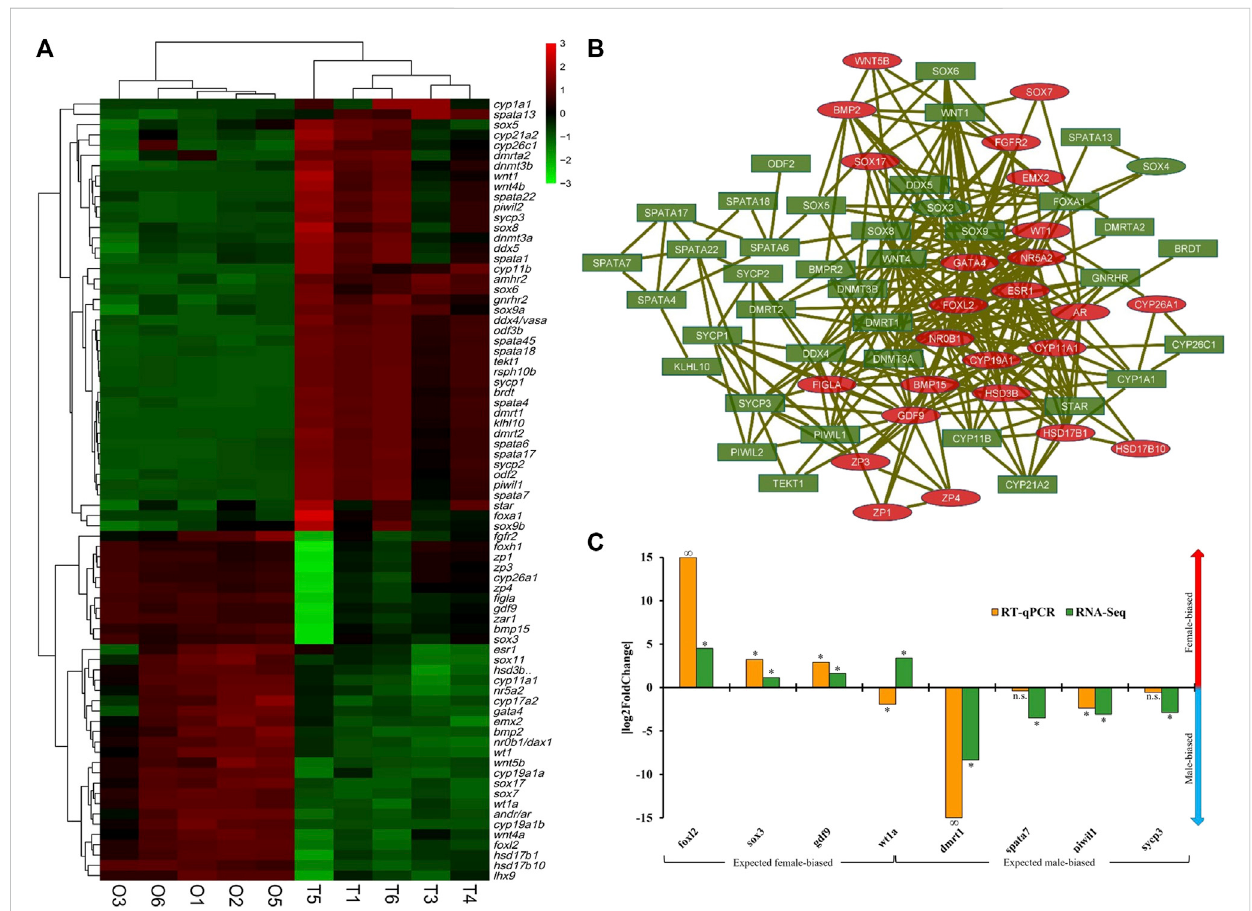
FIGURE 4 Sexually differentially expressed genes (DEGs) of cobia ( p < 0.05). (A) The expression pattern of the representative gonadal genes implicated in sex determination/differentiationofcobia.Intheheatmap,eachrowrepresentsagenelisted ontheright.Eachcolumnstandsfor agonadal sampleofmales (T1, T3, T4, T5, T6) and females (O1, O2, O3, O5, O6). The expression of genes is colour coded from low (green) to high (red). M: male-biased, F: female- biased. (B) The testis upregulated (green with rectangle shapes) and ovary upregulated sex candidate genes (red with oval shapes) were fi ltered into theDEG PPI network complex. Nodes represent genes, edges represent correlationbetweennodes. (C) Validationof theexpressionpatterns ofselected signi fi cantly expressed DEGs from RNA-Seq, using qPCR. Positive |log2FoldChange| indicates female-biasness, negative values indicate male-biasness. ‘ * ’ represents signi fi cant difference betweentestes and ovaries ( p-value < 0.05 ), n.s. Represents non-signi fi cance, ‘ ∞ ’ represents in fi nite log2FoldChange for RT-qPCR